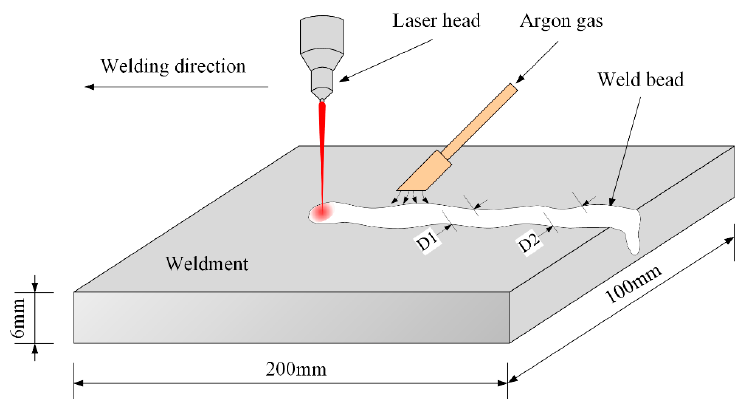
Figure 1. Schematic diagram of laser keyhole welding process.